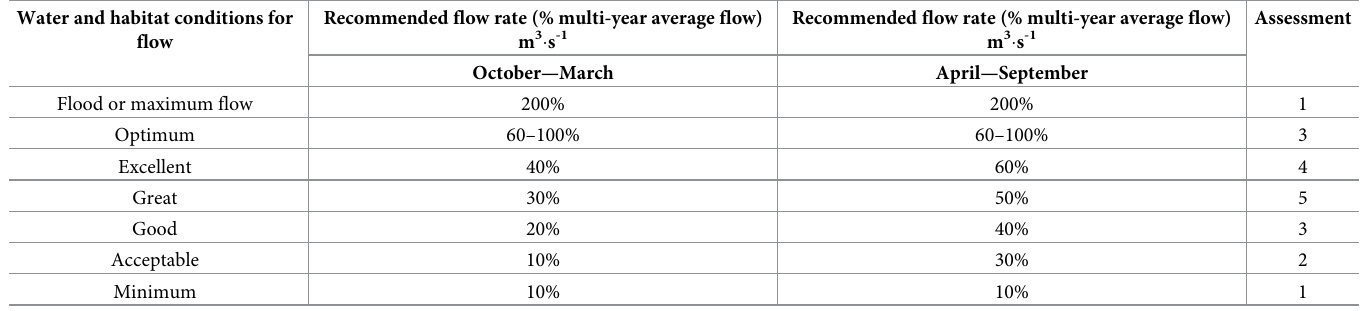
Table 2. Summary of river ratings concerning environmental